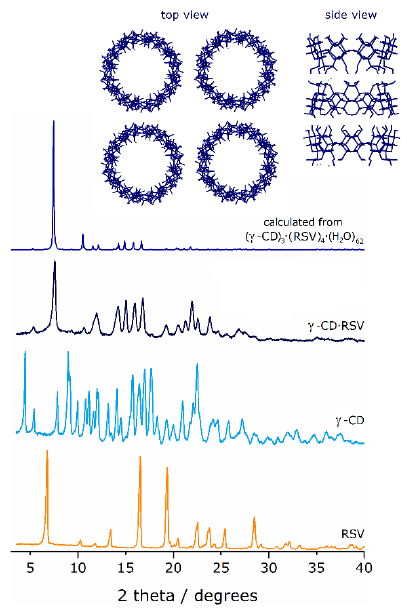
Figure 2. Experimental powder X-ray diffractograms (PXRD) of RSV, γ-CD, and the γ-CD·RSV complex (rehydrated overnight to restore its microcrystalline structure); also shown for comparison is the trace of (γ-CD) 3 ·(RSV) 4 ·(H 2 O) 62 , calculated from its single-crystal atomic coordinates [17]. Structural data for this complex (refcode MUXBIT) was obtained from CCDC and the PXRD was calculated using the software Mercury 3.5.1 (Copyright CCDC 2001–2014). The inset depicts the top and side views of the complex, with γ-CD units aligned in the form of channels (disordered RSV not shown).